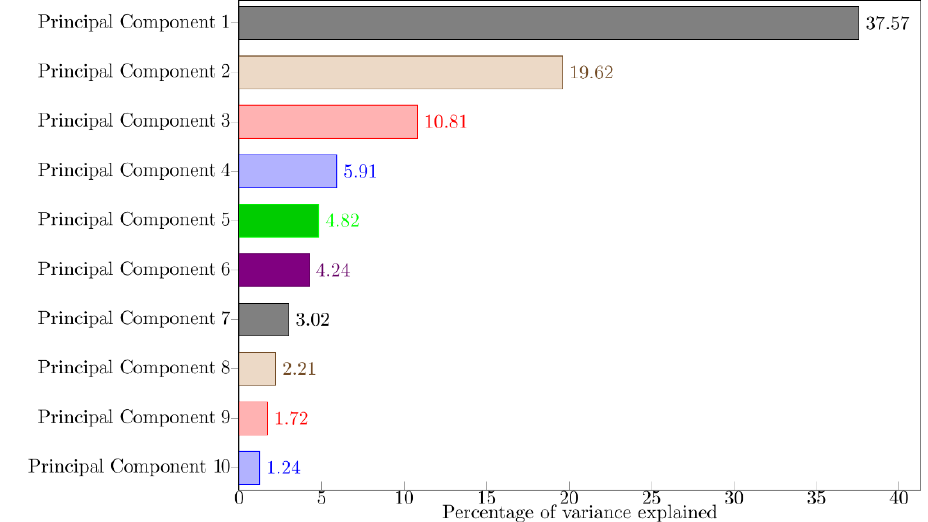
Figure 13. Ratio of explained variance of the first 10 principal components of the data. Table 1. Average F 1 score and corresponding time for training and evaluation of data stemming from transducer 3, excited with a 3 cycles burst for all subjects. The best performance for each column is depicted in green, and the second-best performance is depicted in